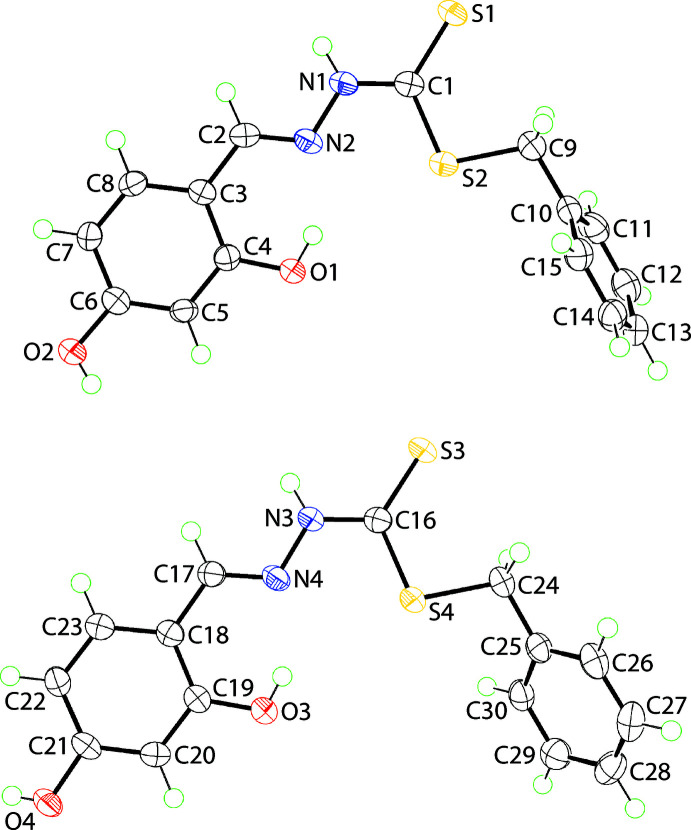
The mol­ecular structures of the two independent hydrazine carbodi­thio­ate mol­ecules in (I) showing the atom-labelling scheme and displacement ellipsoids at the 70% probability level.